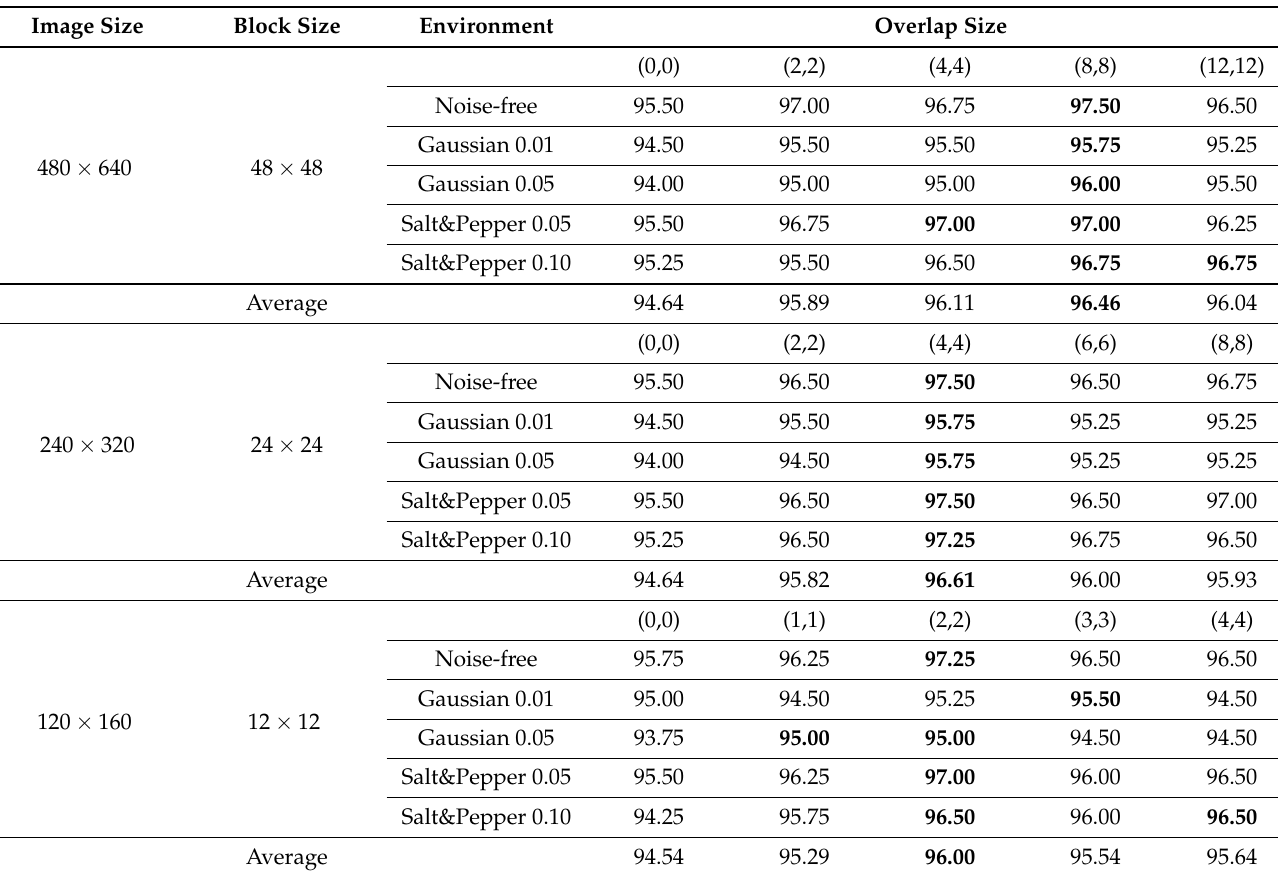
Figure 6. Samples of the FEI dataset. Table 5. The reported face recognition accuracy (%) for the FEI dataset using the proposed